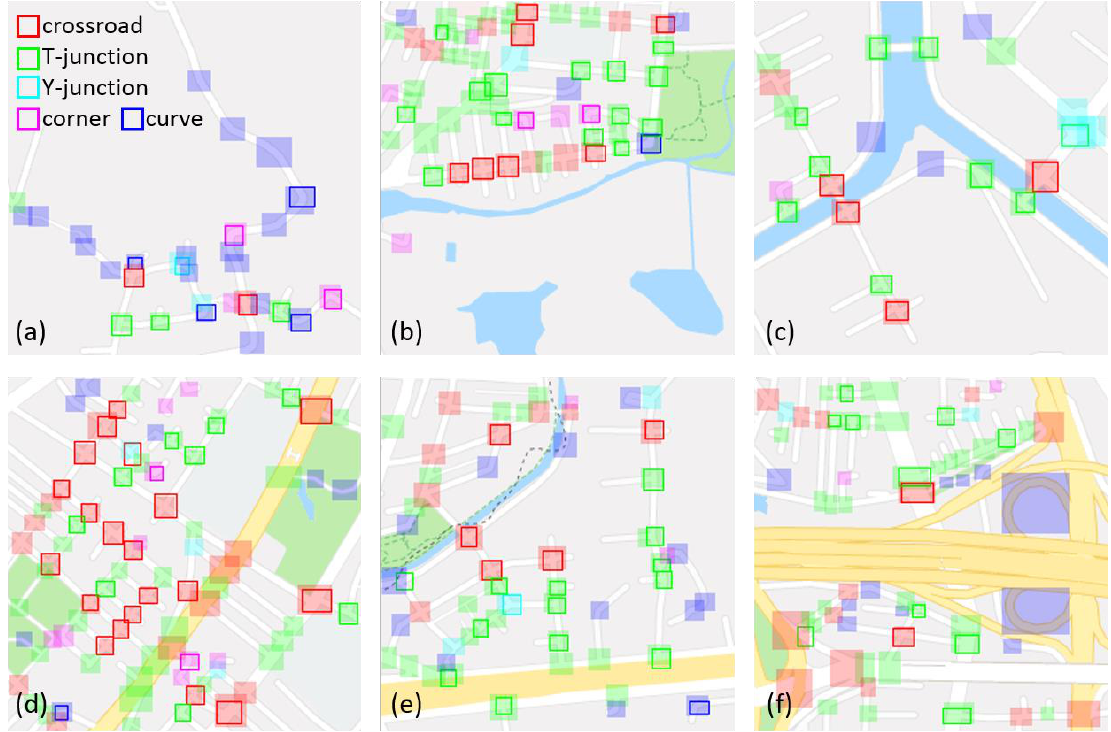
Figure 10. Faster R-CNN results overlaid on ground truth results that are marked as color-filled areas: ( a ) 54897_28039_16, ( b ) 54880_28041_16, ( c ) 54876_28052_16, ( d ) 54873_28067_16, ( e ) 54908_28051_16, and ( f ) 54888_28049_16.